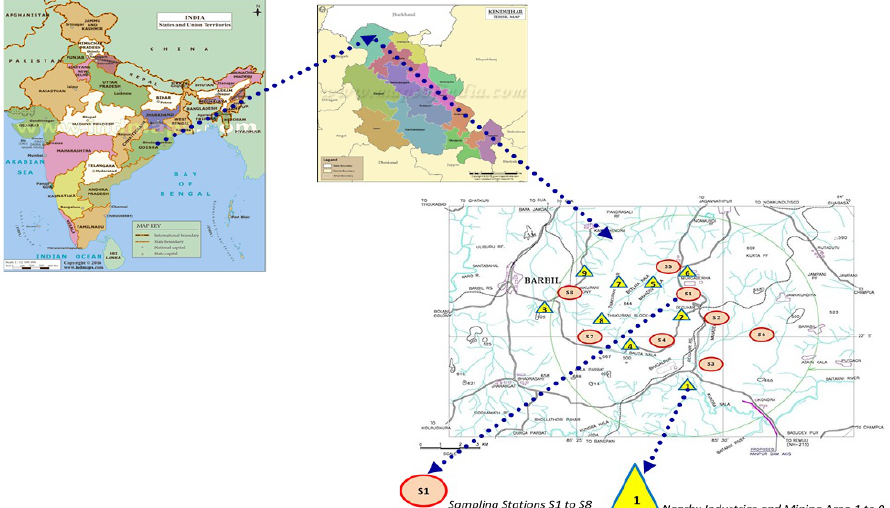
Fig. 1: The study area details